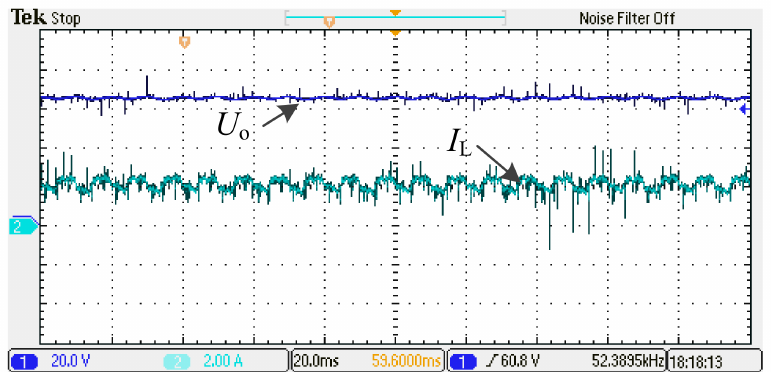
Figure 16. Output voltage and inductor current with conventional solution.